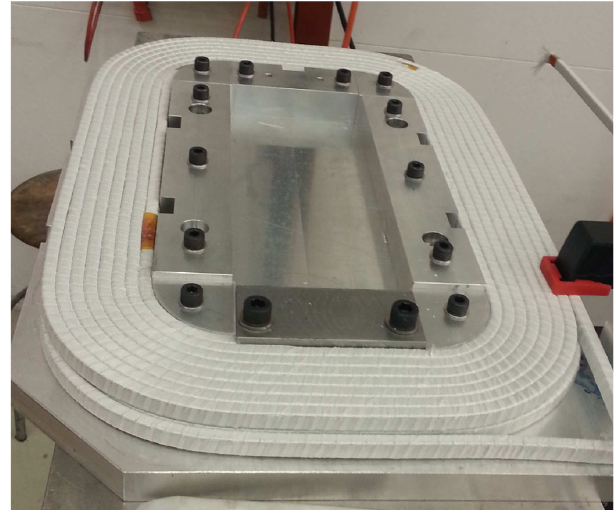
FIG. 13. Coil winding performed